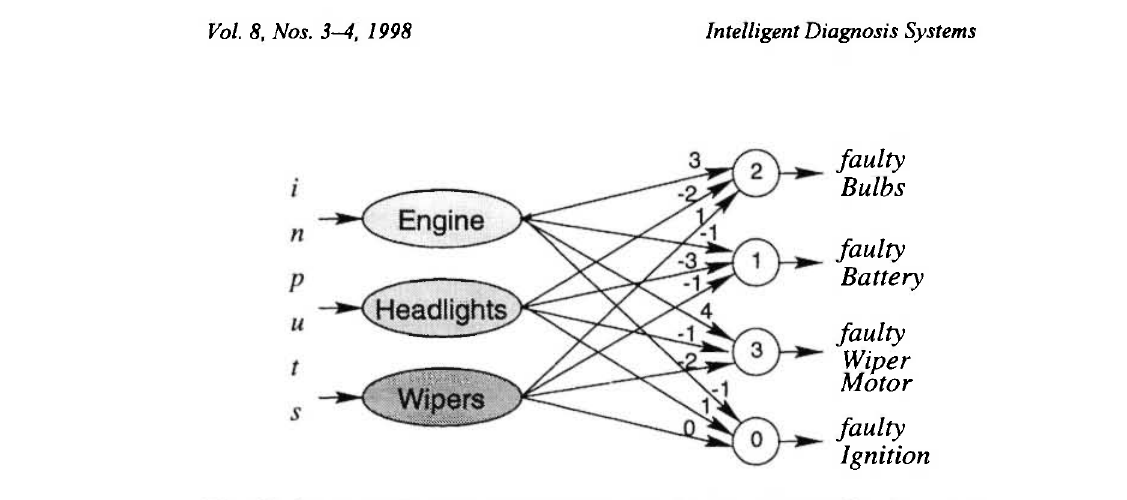
Fig. 10: An example connectionist network for the automobile diagnosis problem constructed using perceptron learning. The network contains three input units and four output units that compete for domination. The unit with the maximum activation is declared the winner and it produces an output of 1. The other units produce an output of -1. The numbers inside the output units represent the additive bias. Input units receive a value of 1 if the corresponding component works and a -1 when it does not. A 1 at an output unit indicates that the corresponding component is faulty, while a -1 indicates a healthy